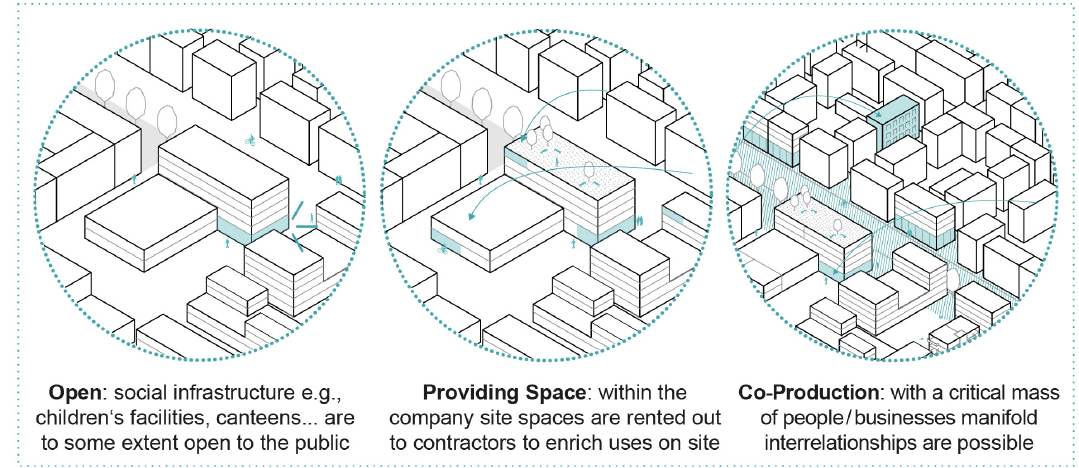
Figure 2. Different types of everyday connectivity (marked in green; see descriptions in Subsections